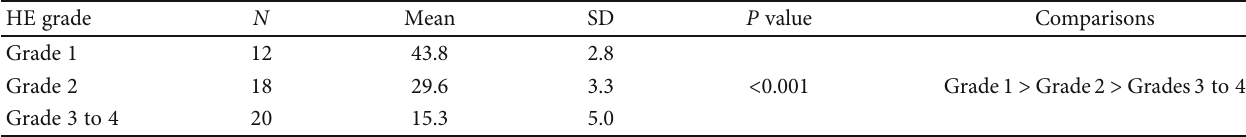
Table 9: Comparison of 25-OHD level in di ff erent HE grades.